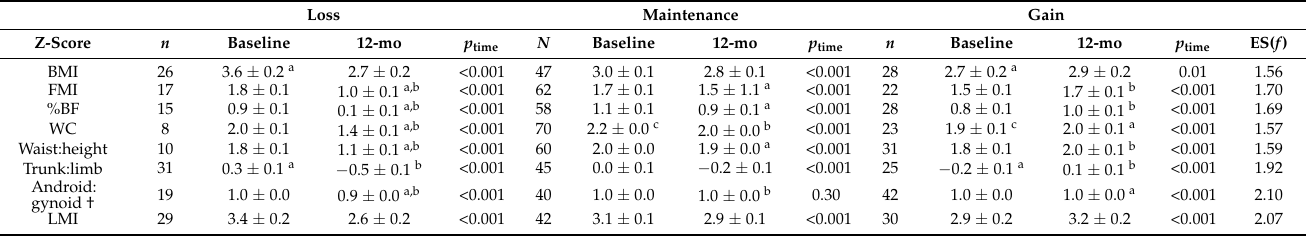
z-score, waist:height z-score, and LMI z-score (Table 3). There was a low to medium effect on 25(OH)D by the change in android:gynoid (Table 3). Table 2. Change in z-score between baseline and 12 mo in those who lost, maintained, and gained in each adiposity